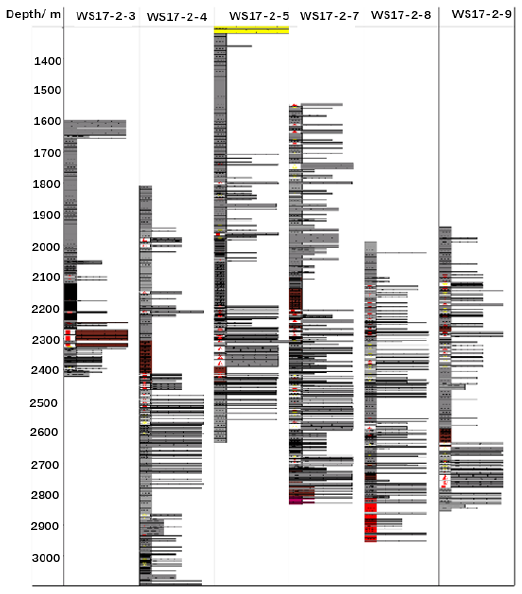
Figure 2. Lithology section of Liushagang Formation.